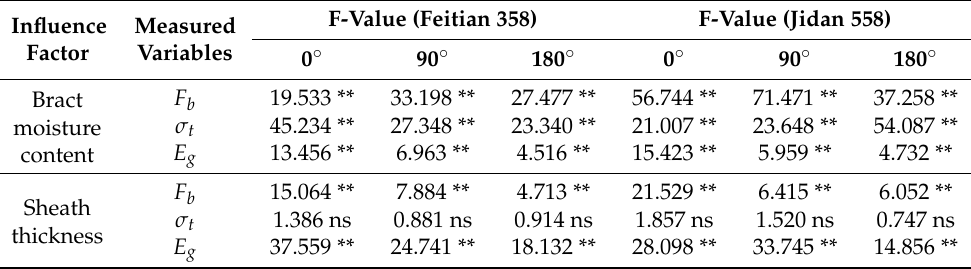
Table 5. Repeated measures analysis of variance for tensile properties of leaf